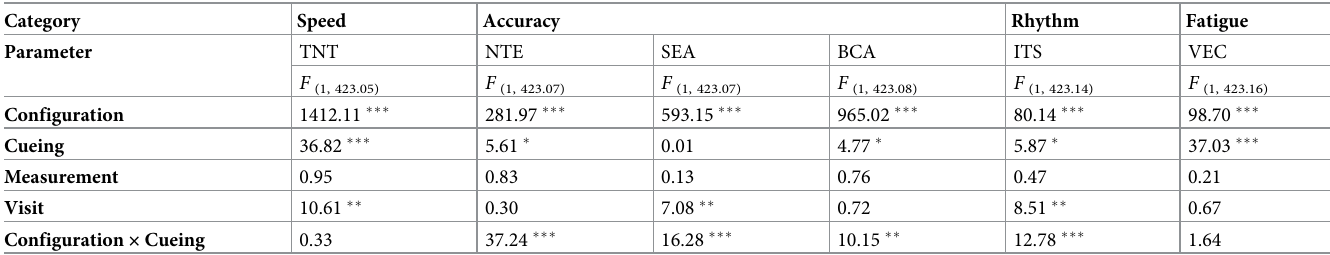
Table 6. F-Test results of fixed effects for each